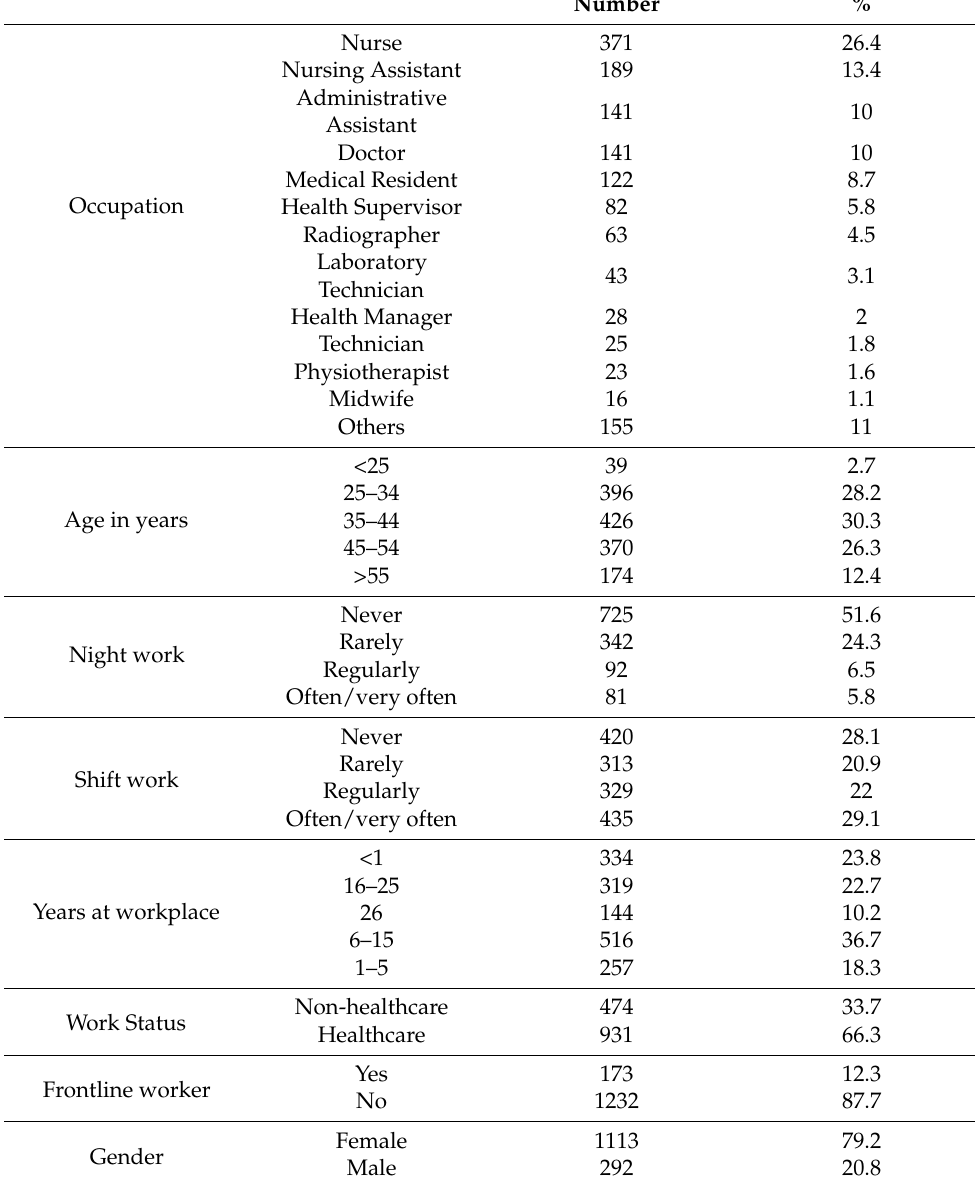
Table 1. Demographic and occupational characteristics of study